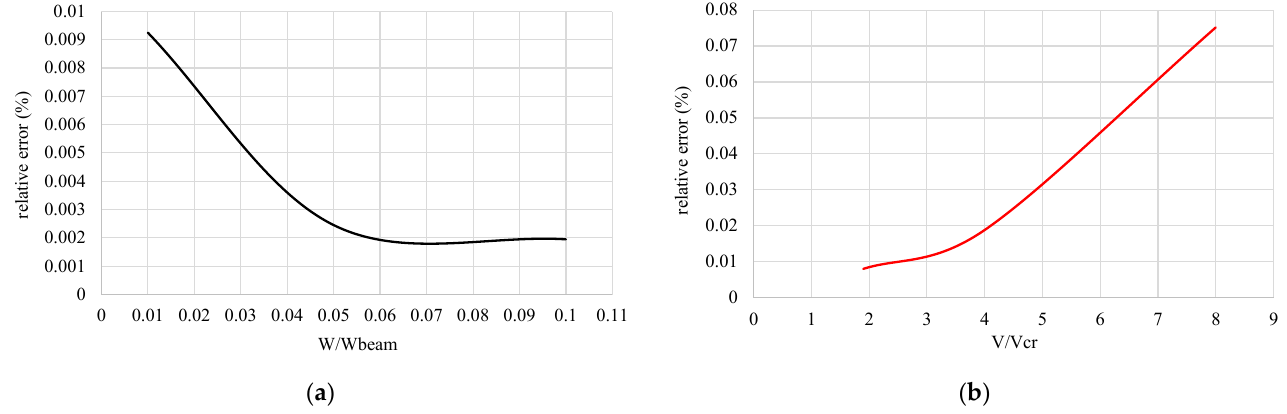
Figure 33. Moving load estimations using displacement sensors: ( a ) weight; ( b ) velocity estimation of the moving load.